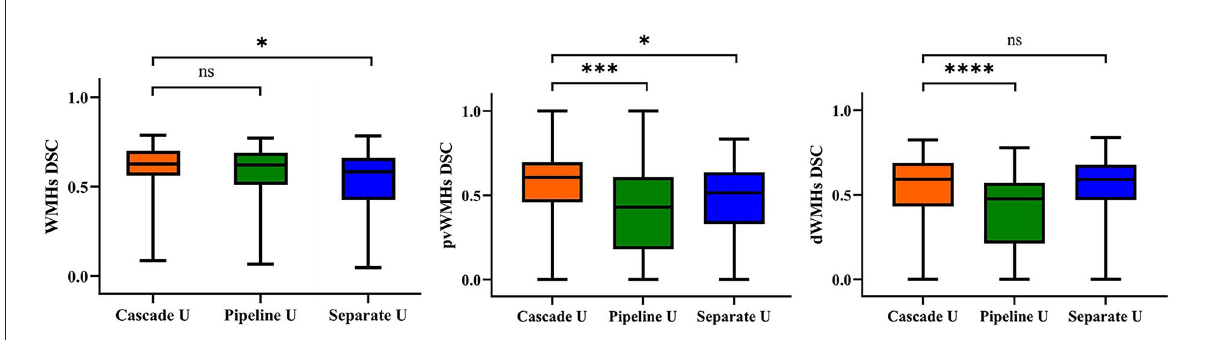
FIGURE3 Statistical evaluation of WMHs, pvWMHs, and dWMHs segmentations using DSC. Not significant: ns, p < 0.05: * ; p < 0.001: *** ; p < 0.0001: ****